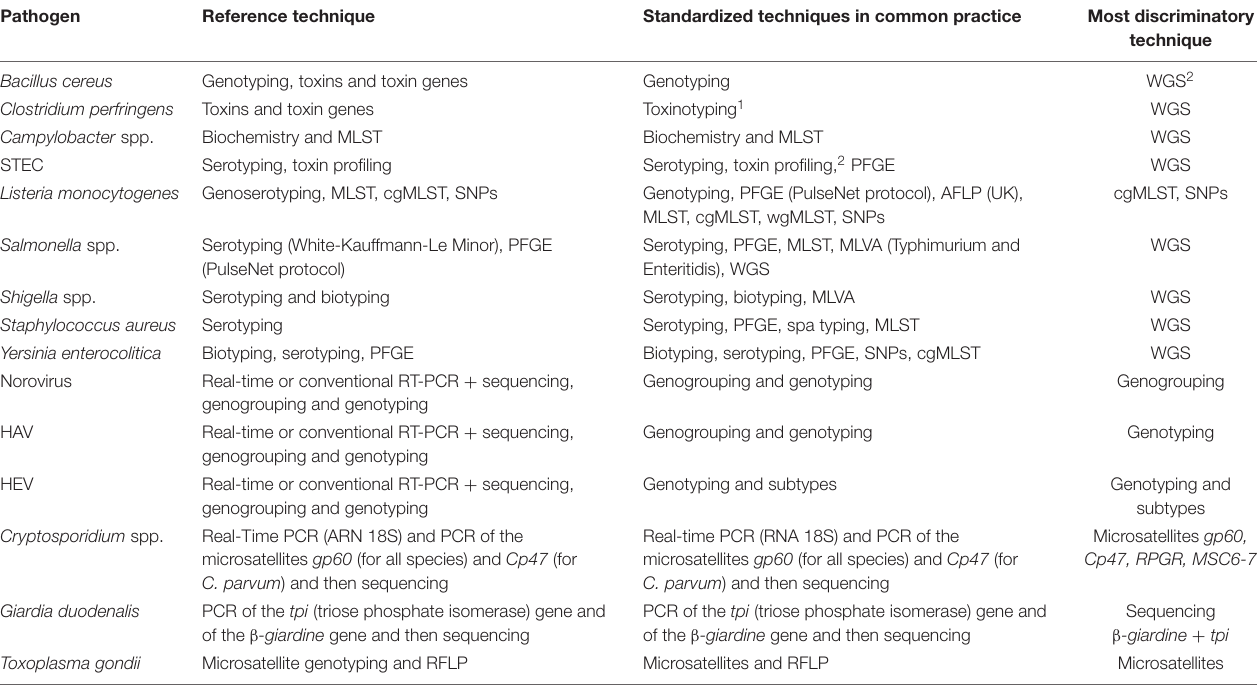
TABLE 2 | Typing techniques of reference, those routinely used and those most discriminatory per each foodborne